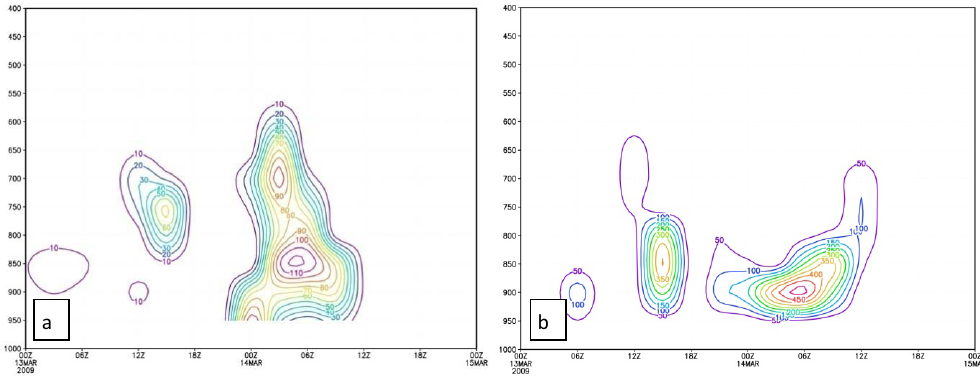
Fig. 7.Forecasts of the vertical profile of the cloud water contents (10-6 kg/kg), at 47° N Fig. 7. Forecasts of the vertical profile of the cloud water content (10 − 6 kgkg − 1 ), at 47 ◦ N and 38 ◦ E valid for 13 and 14 March 2009 for and 38° E valid for 13 and 14 March 2009 for (a) CTL and (b) EXP. Contour interval is (a) CTL and (b) EXP. Contour interval is 10. The x-axis shows the time from 00:00 UTC 13 March to 00:00 UTC 15 March 2009. Vertical 10. The x axis shows the time from 00 UTC 13 March to 00 UTC 15 March 2009. axis shows pressure levels from 1000 to Vertical axis shows pressure levels from 1000 to 400 hPa.